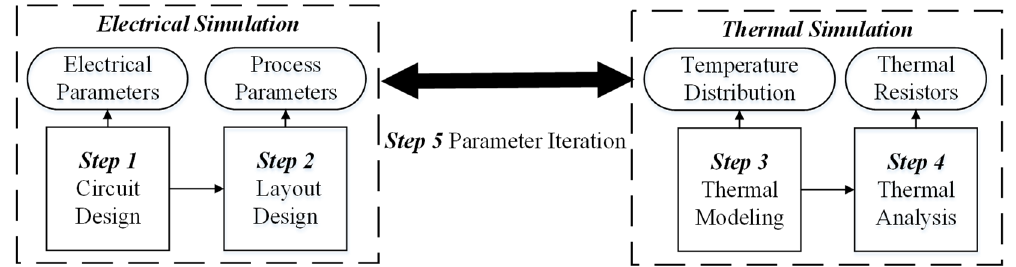
Figure 3. Procedure of proposed co-simulation method.